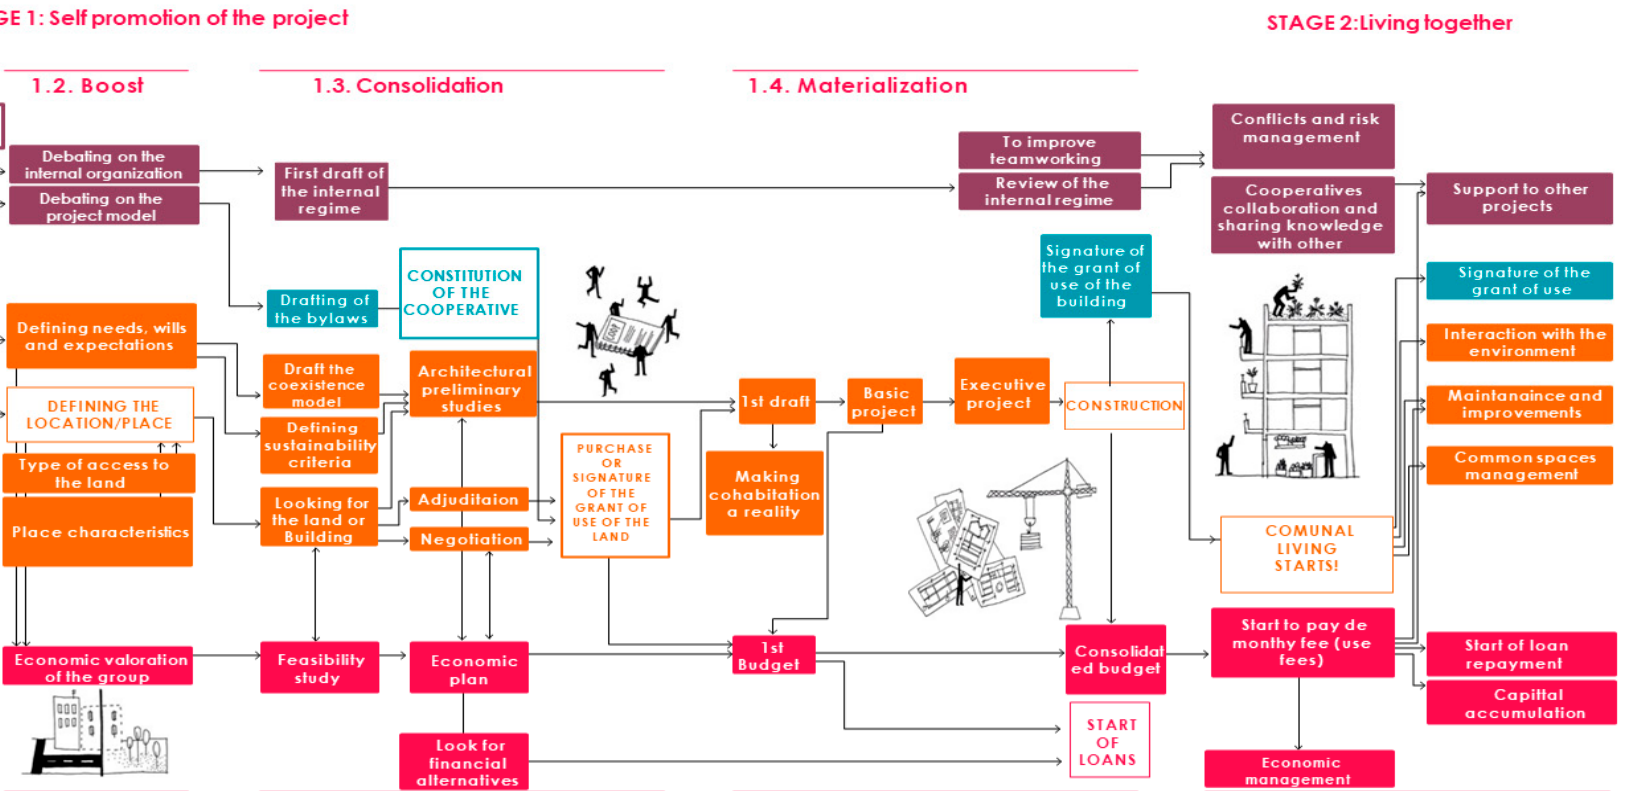
Figure 1. Stages of the cooperative housing under a GoU